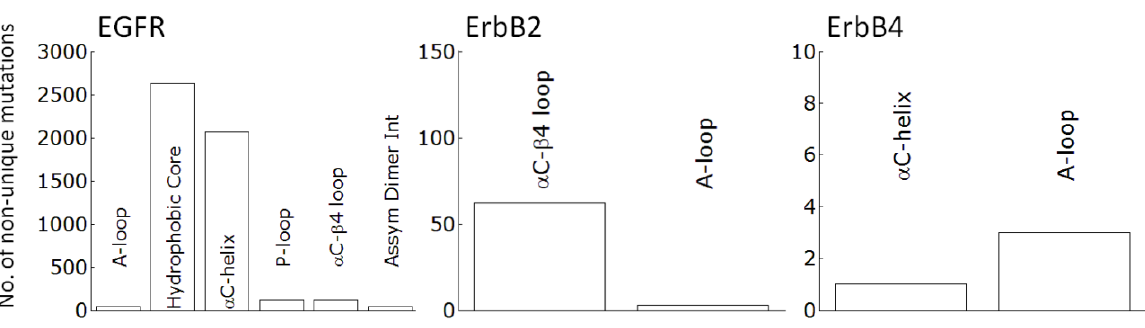
Figure 2. Non-unique mutations cataloged in cancer samples for the ErbB family in catalytically important sub-domains, curated from the COSMIC